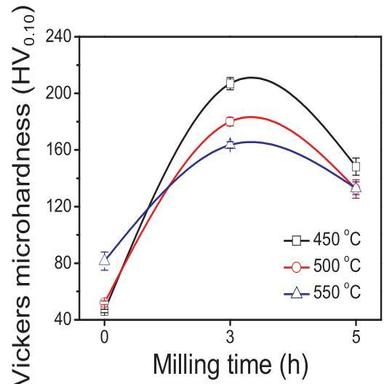
Vickers microhardness of Al-Cu-Mg/WC composites obtained with different sintering temperatures as functions of milling time.